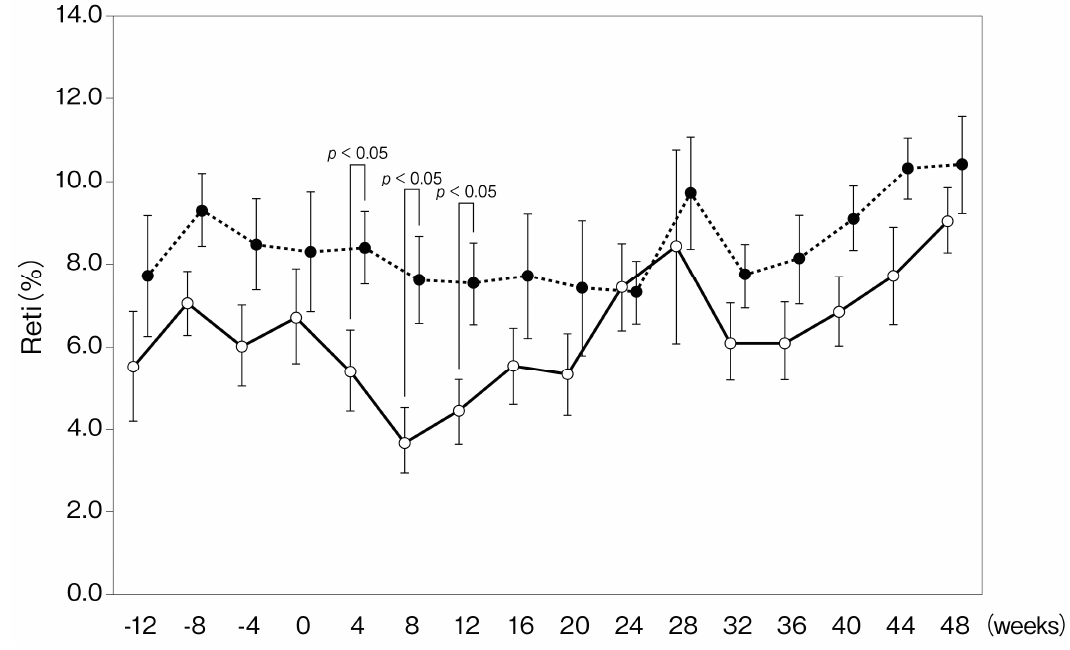
Figure 2. Change in reticulocyte (Reti) concentration. Solid line, darbepoetin α continuation group; dotted line, continuous erythropoietin receptor activator. Table 2. Doses of darbepoetin α (DA) and continuous erythropoietin receptor activator (CERA) during the fixed dose period and the evaluation period.